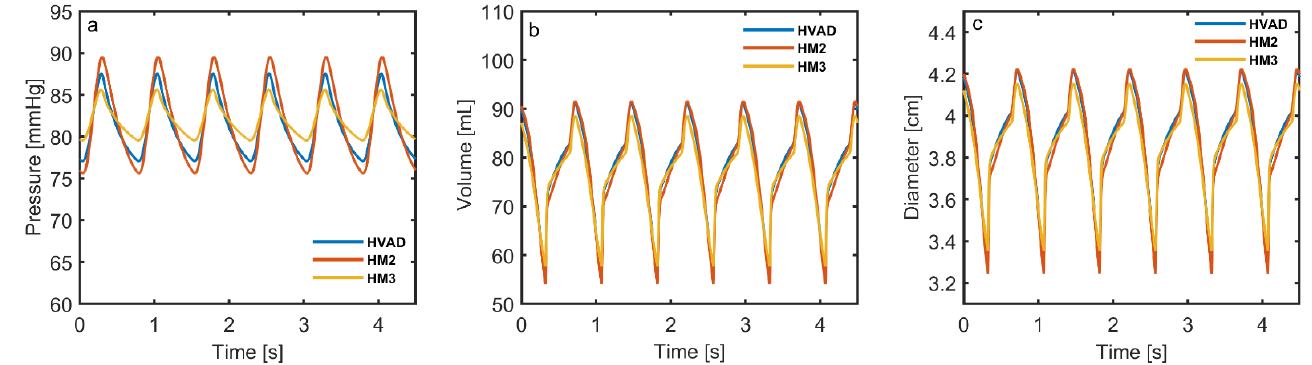
Figure 3. ( a ) Aortic pressure, ( b ) left-ventricular volume, ( c ) left-ventricular diameter under HVAD, HM2 and HM3 support.